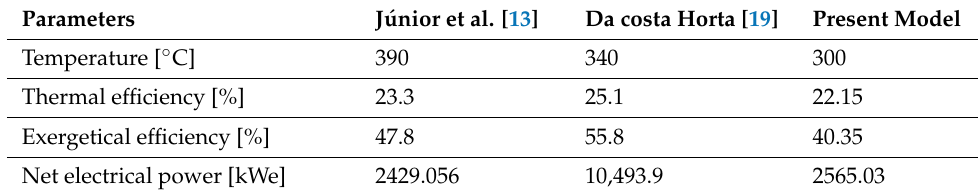
Table 13. Comparison with different results in the literature.